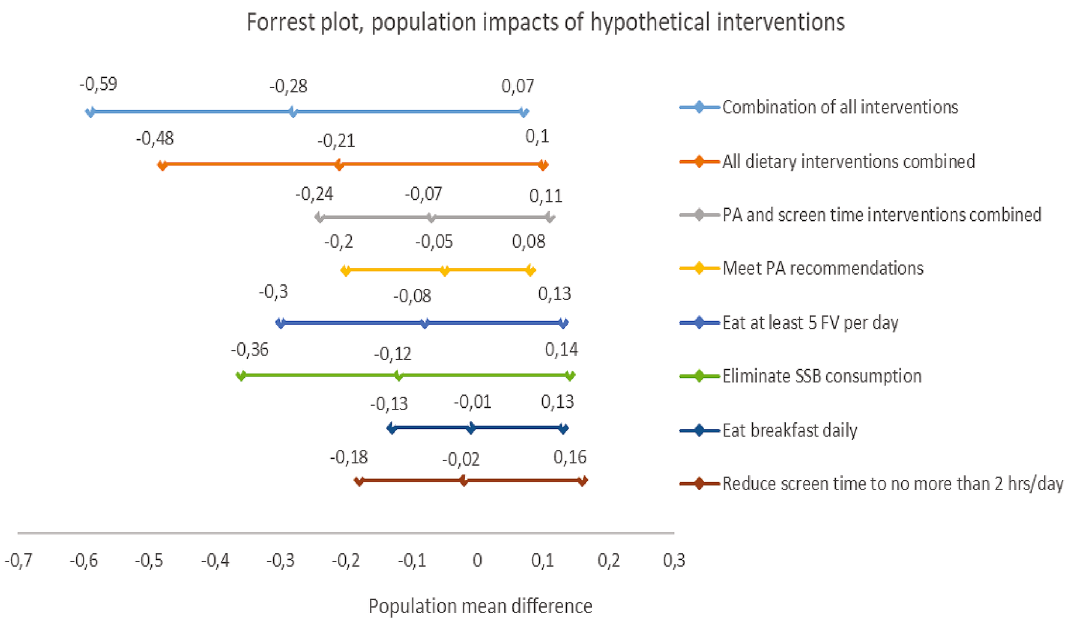
Figure 1. Impacts of hypothetical behavioral interventions at age 11 on BMI at age 13. FV fruits and vegetables, PA physical activity, SSB sugar-sweetened beverages. Adjusted for age, puberty, sex, parental education, BMI at age